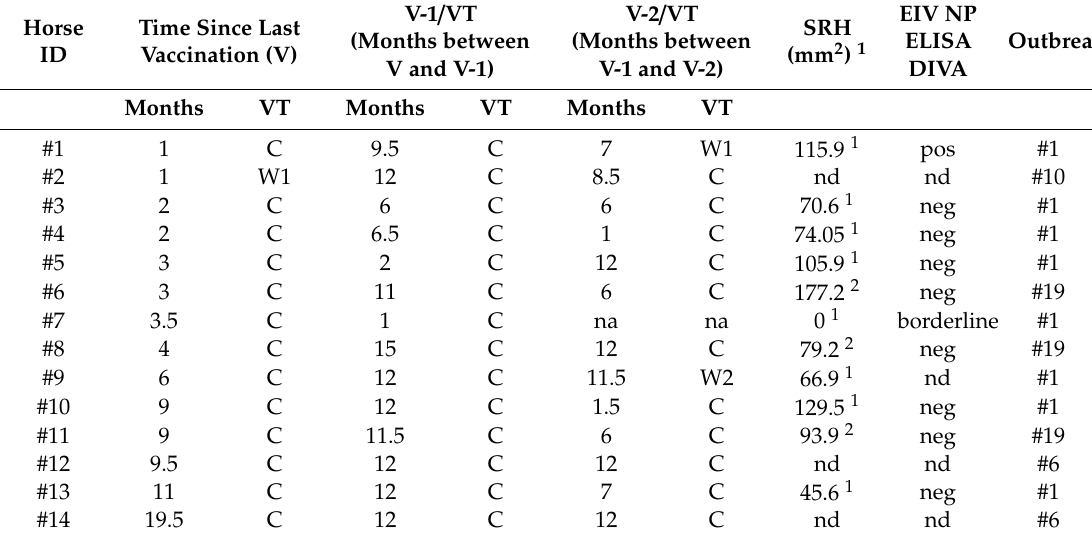
Table 2. EI clinical cases with known EI vaccination history: time since last vaccination and EIV-specific antibody responses (SRH and EIV NP ELISA) at the onset of clinical signs of disease: na = not applicable; nd = not done; neg = negative; pos = positive; V = last EI vaccine administered prior to EI outbreak; VT = vaccine type: C = EIV HA recombinant canarypoxvirus-based EI vaccine ProteqFlu ( ±